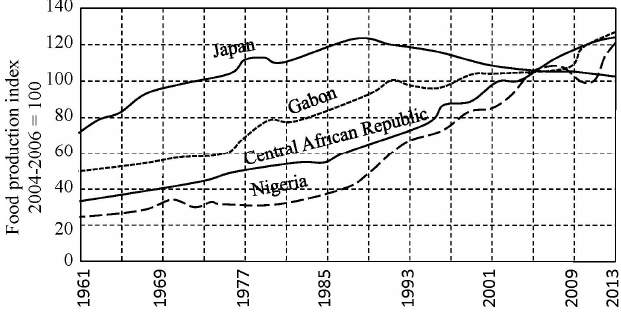
Figure 4. Comparison of food production indicators in developed countries and weakly developed countries.